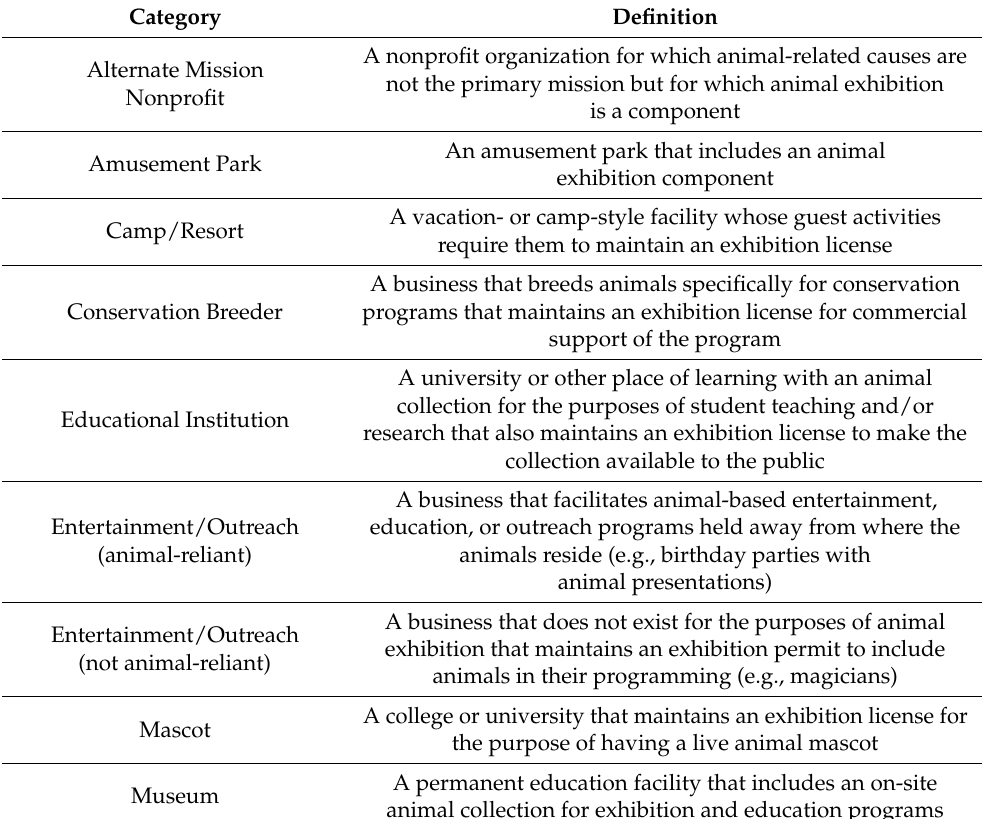
Table 1. USDA Class C Licensed Exhibitor Business